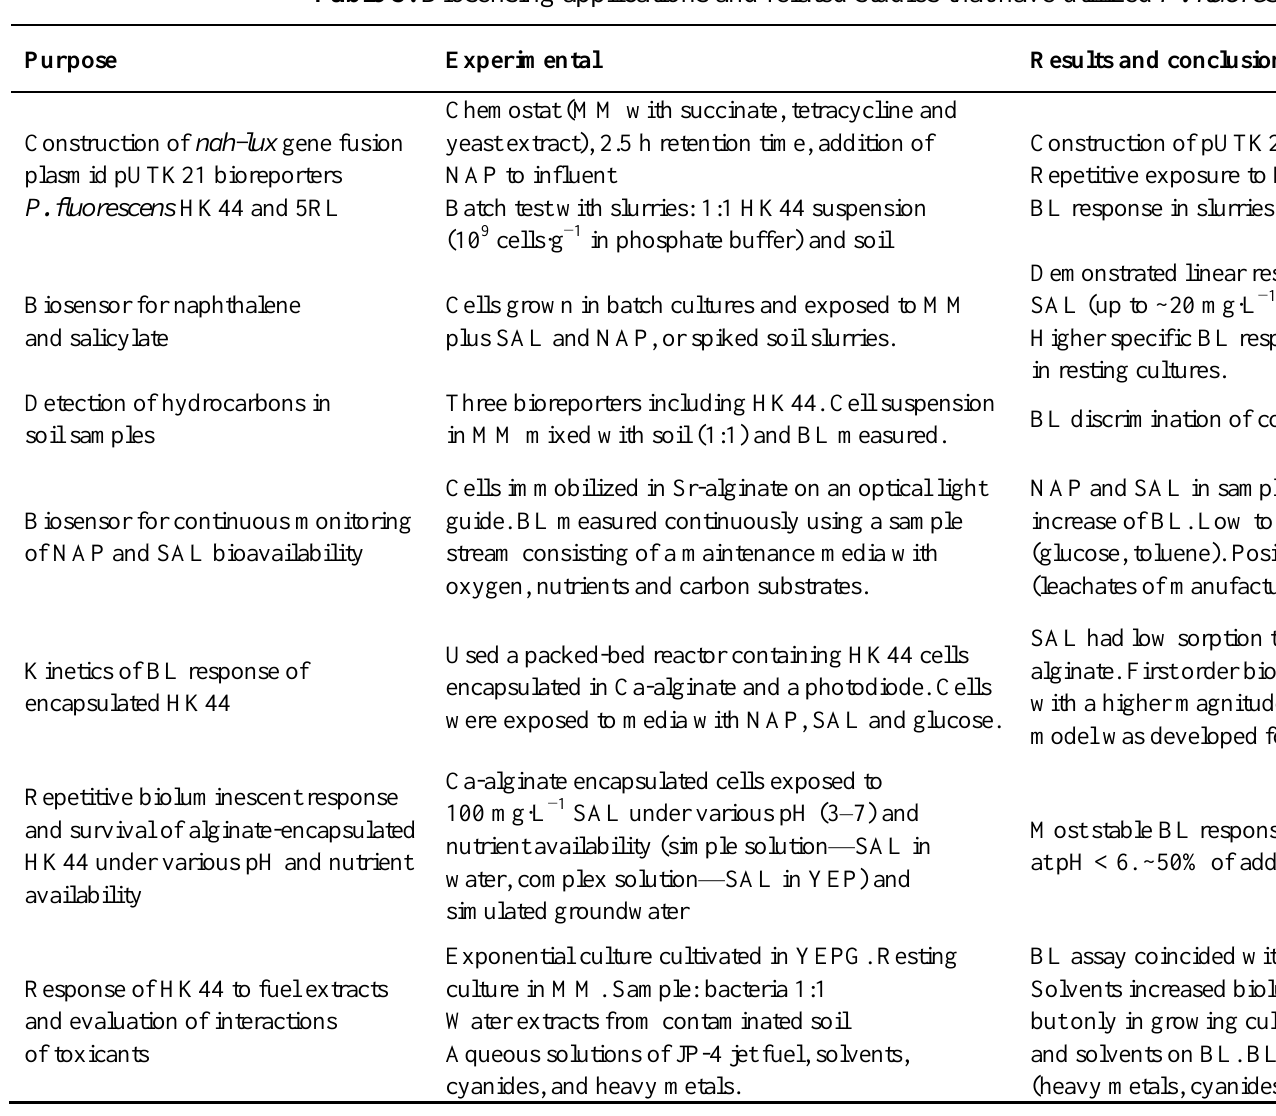
Table 3. Biosensing applications and related studies that have utilized P. fluorescens HK44 as a